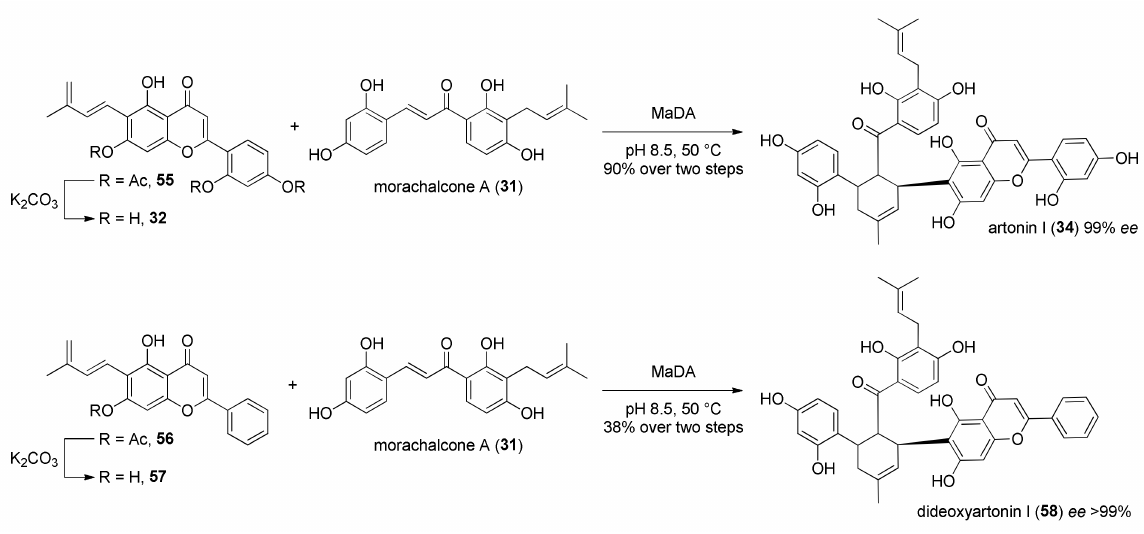
Figure 17. Chemoenzymatic total synthesis of artonin I ( 34 ) and dideoxyartonin I ( 58